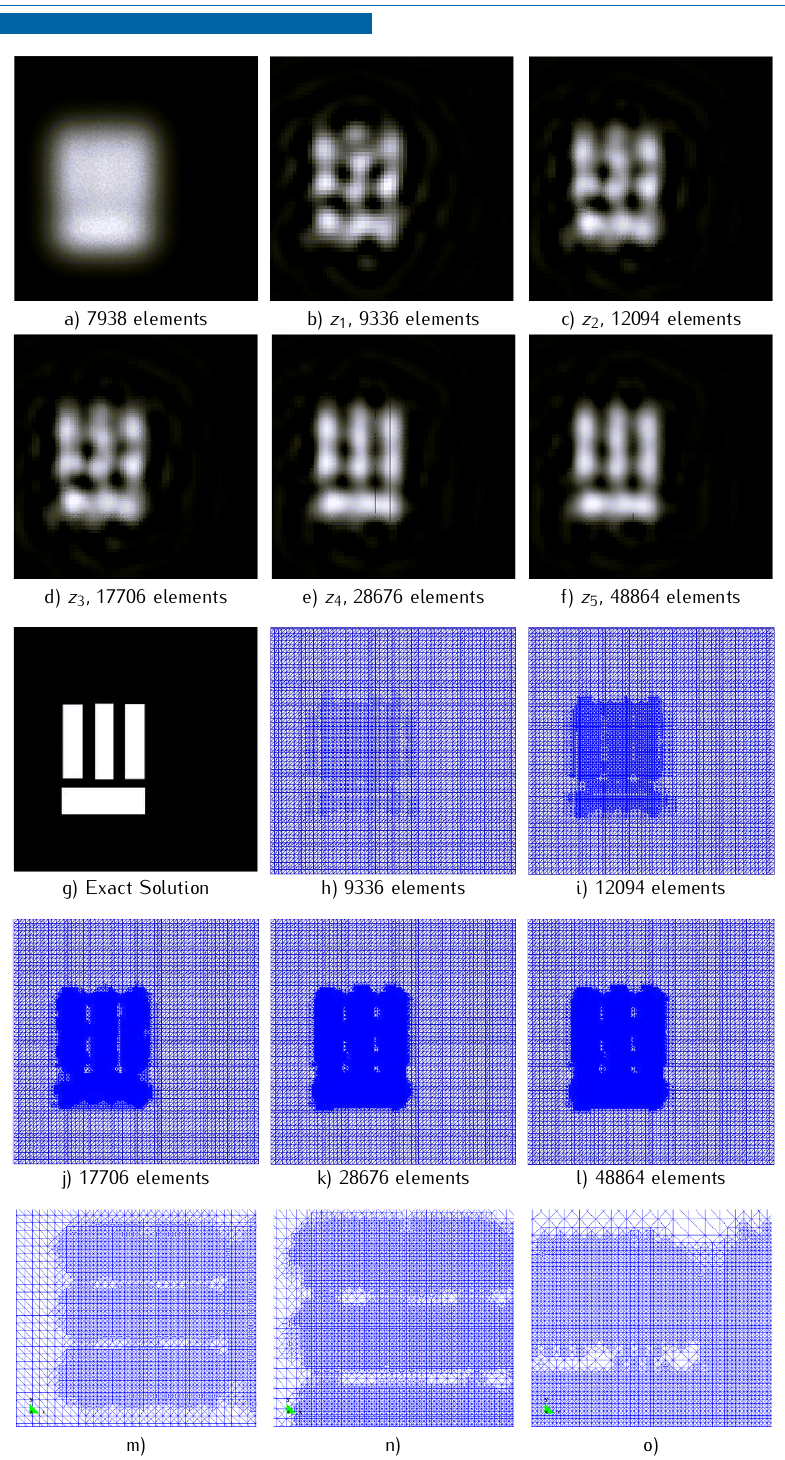
Figure 1. Test 1-a). Reconstruction of the function z ( x 1 ,x 2 ) using simulated backscattered data. In a) we present simulated backscattered data u ( ξ,η ) . In b)–f) we show results of the reconstruction of the function z ( x 1 ,x 2 ) on different adaptively refined meshes using the